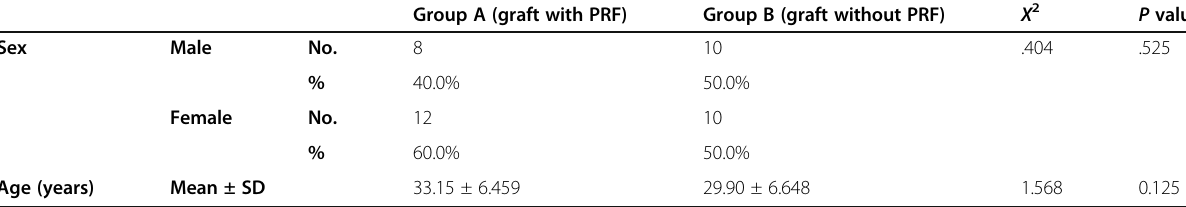
Table 1 Comparison between the study groups regarding demographic